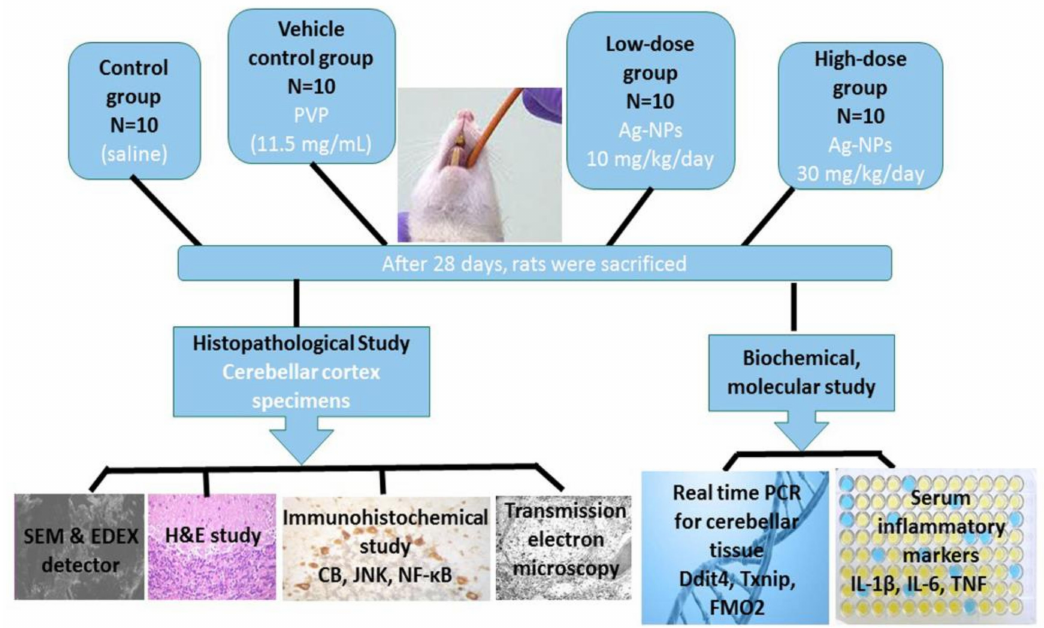
Figure 1. Experimental design and methods of study. Rats were parted randomly into four groups (10 rats each). Group I (control group) received saline in an equivalent volume to that in silver nanoparticles (Ag-NPs)-treated groups. Group II (vehicle control group) received poly vinyl pyrrolidone (PVP) (11.5 mg/mL). Group III (low-dose group) was administered Ag-NPs at a dose of 10mg/kg/day and group IV (high-dose group) was administered Ag-NPs at a dose of 30mg/kg/day. Treatments were given by oral gavage for 28 days. Cerebellar specimens were processed for histopathological preparations and molecular analysis. Blood samples were taken for biochemical